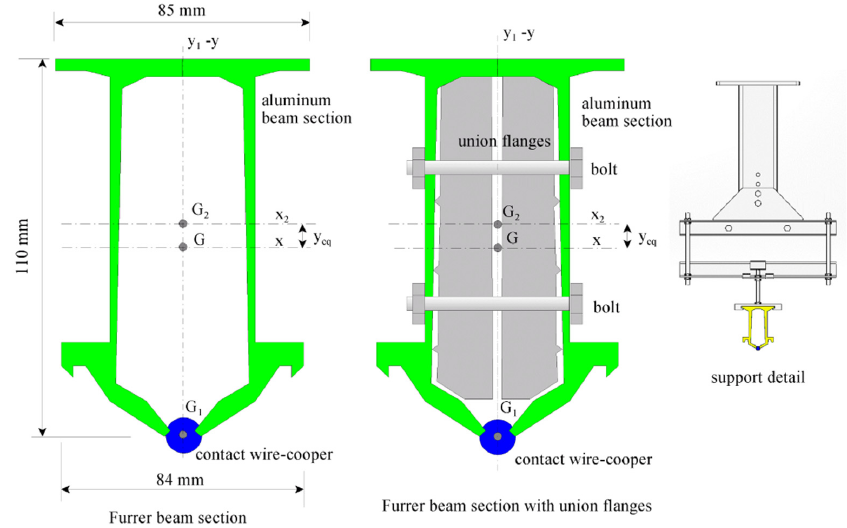
Figure 3. Details of the Furrer-type section and the fastening system.